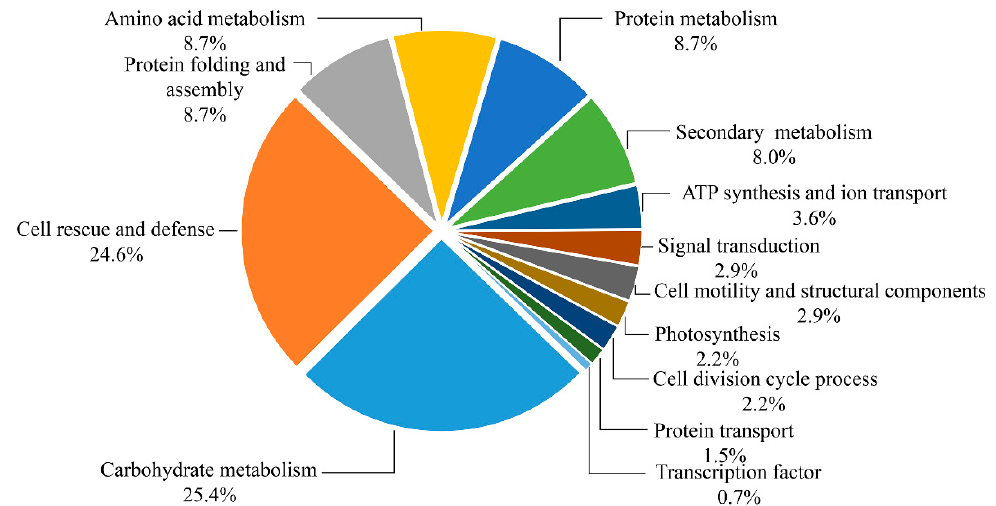
Figure 6. Functional classification of 138 identified proteins. Distribution of proteins according to their biological functions.